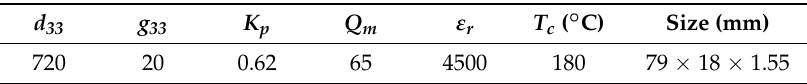
Table 1 . Part parameters of piezoelectric transducers. Table 1. Part parameters of piezoelectric transducers.